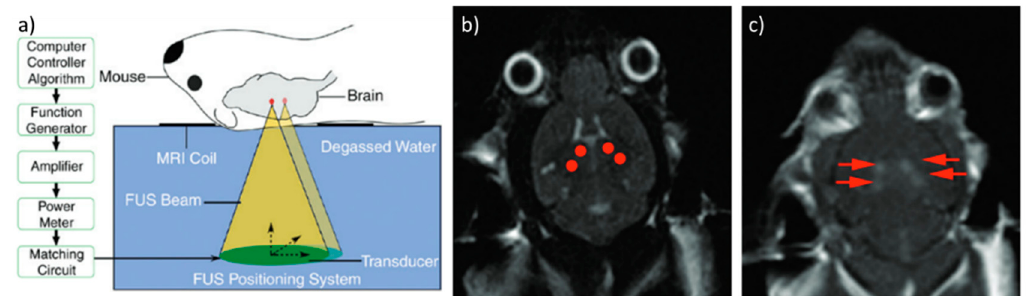
Figure 3. Opening the blood brain barrier (BBB) by focused ultrasound (FUS) and microbubbles in mice. The ( a ) setup utilises a coregistered magnetic resonance imaging (MRI) to identify targets in the brain. The targets in the mouse hippocampus are ( b ) marked on the image as red dots and FUS is applied after an injection of Definity® microbubbles. After treatment, a gadolinium-based MRI contrast agent is injected. Typically unable to cross the blood brain barrier, after treatment ( c ), an enhancement of contrast is seen at the target sites in the mouse hippocampus. Reprinted with permission from the Radiological Society of North America, Radiology [117].